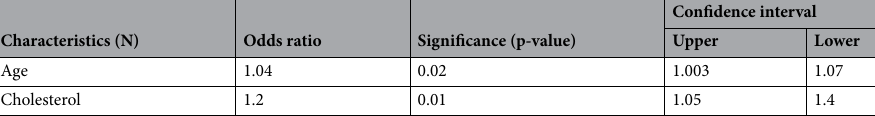
Table 5. Odds ratios for factors associated with DKA with AP (multivariate logistic regression analysis). DKA Diabetic ketoacidosis, AP acute pancreatitis. Odds ratios adjusted for gender, admission WBC